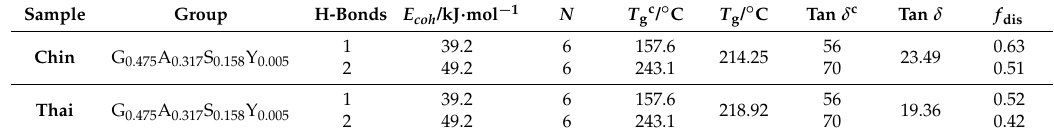
Table 4. GIM parameters used for T g and the degree of structural disorder f dis calculations b*